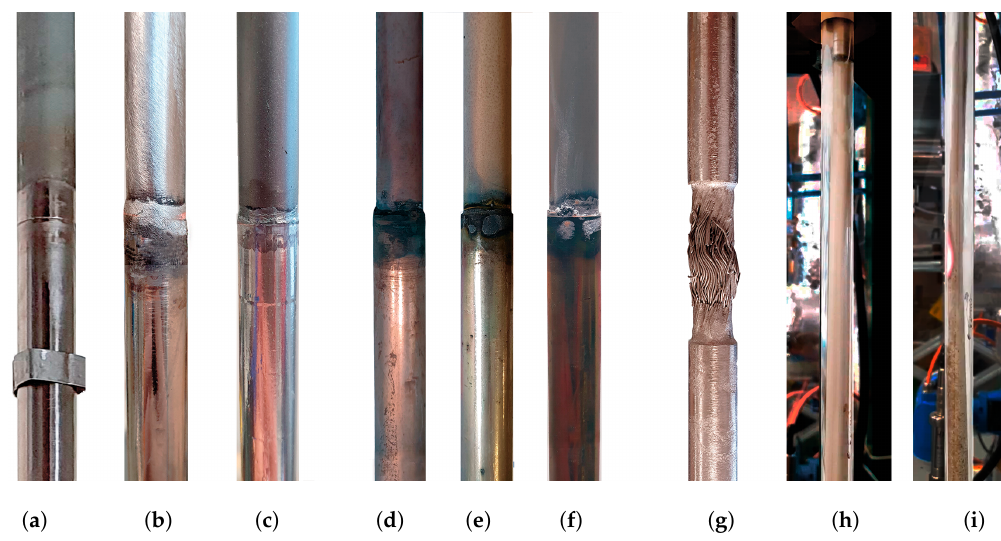
Figure 3. ( a ) bottom connection of IN to the copper electrode (with a spacer below); ( b ) upper connection of IN150 to the copper electrode; ( c ) upper connection of INB to the copper electrode; ( d ) upper connection part of IN after experiments; ( e ) upper connection part of IN150 after experiments; ( f ) upper connection part of INB after experiments; ( g ) thermal dilatation joint; ( h ) bending of the heated IN150 tube at the boiling crisis; ( i ) glowing of already oxidized IN150